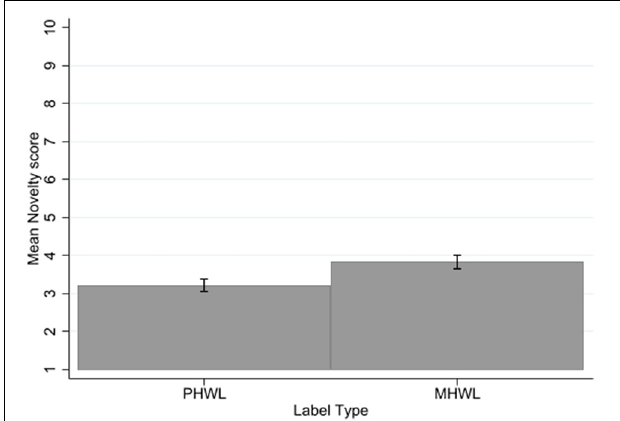
FIGURE 8 | Novelty by label type. Error bars represent 95% confidence intervals.